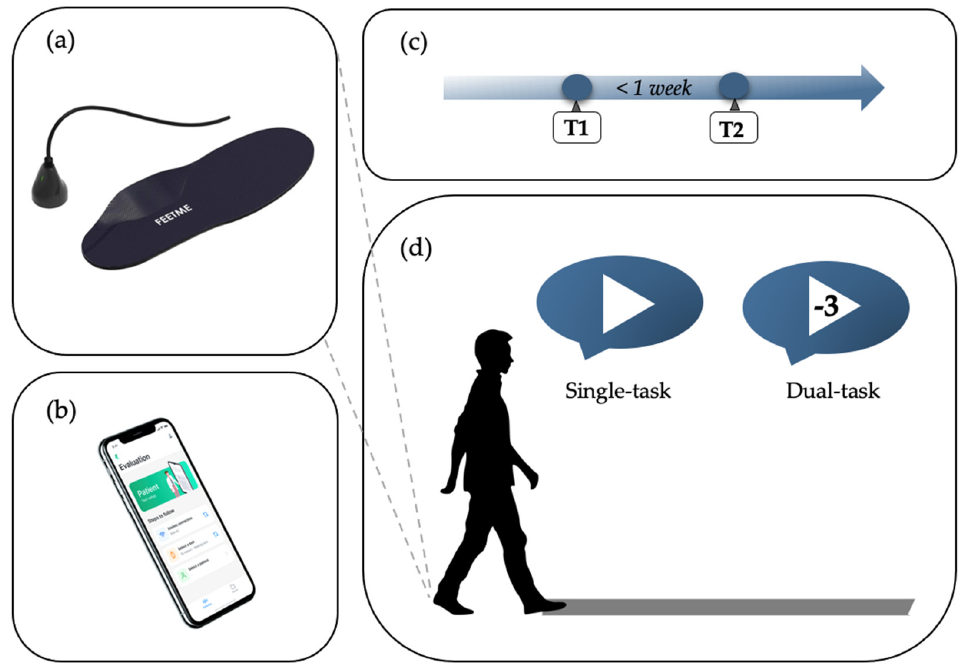
Figure 1. Schematic representation of the instrumentation and experimental procedure applied. ( a ) Pressure − sensing FeetMe ® insoles [20]; ( b ) the FeetMe ® evaluation mobile app to collect gait data from insoles [20]; ( c ) the gait assessment timeline; ( d ) the experimental protocol applied during a gait assessment.